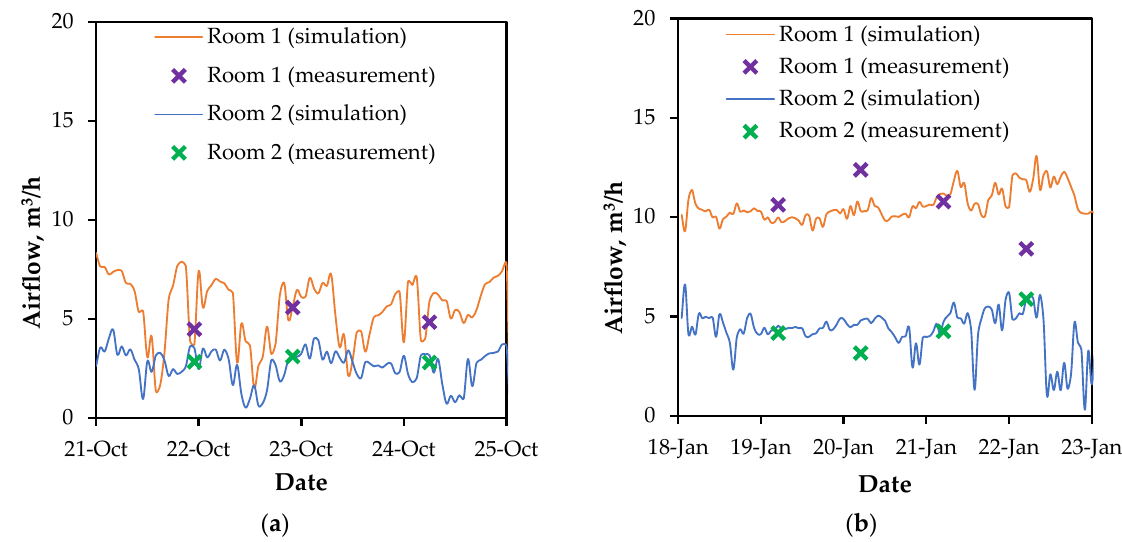
Figure 6. Airflow variation in rooms—comparison of measurement and simulation results: ( a ) transitional period; ( b ) winter period.